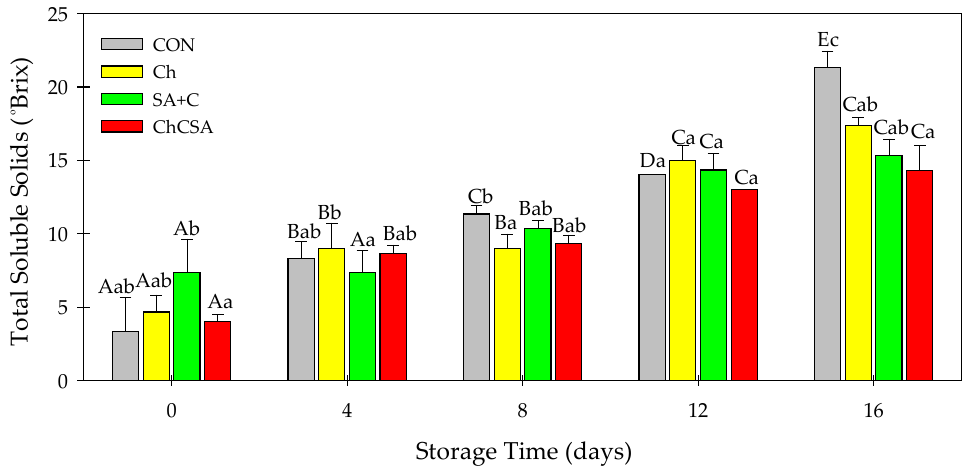
Figure 7. The effect of layer-by-layer and single-layer coatings on the percentage of o Brix of fresh-cut purple sweet potatoes. Vertical bars represent means and standard deviation. Bars with different alphabets within the same storage day (lower case) or same treatment group at different storage days (upper case) are significantly different (Tukey’s HSD Test, p ≤ 0.05).